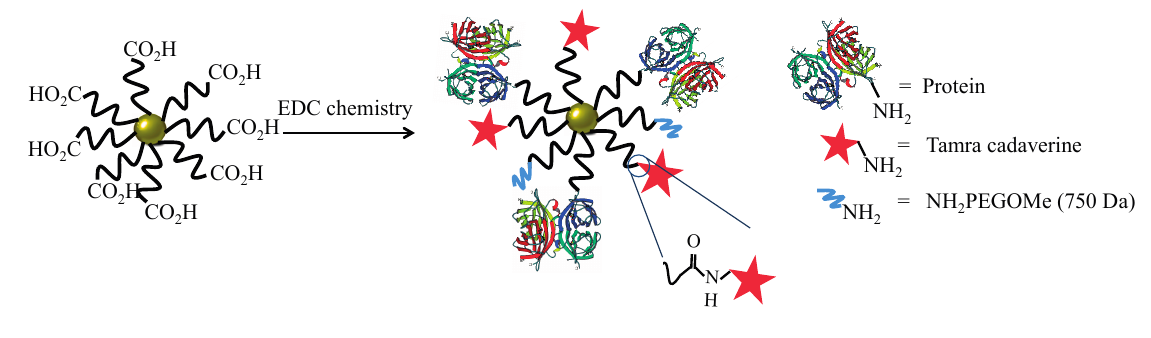
Figure 6. Scheme of the NP modification with antibody, dye and PEG (as passivating